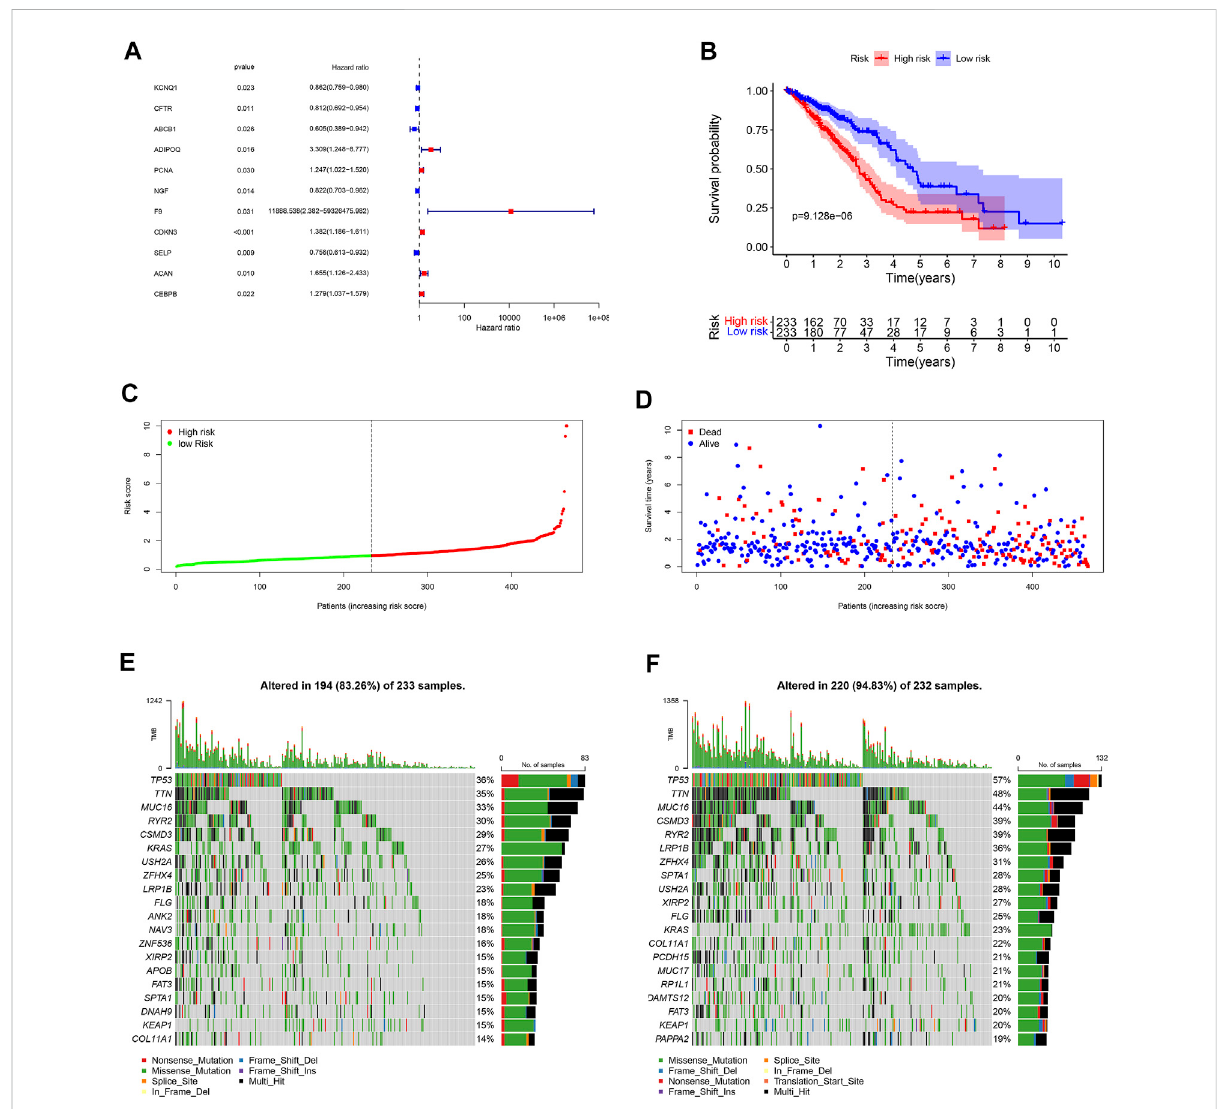
FIGURE 4 LandscapeofUPPandprognosisinLUAD. (A) 11UPP-relatedgeneswereobtainedbyunivariateCoxanalysis. (B) Survivalanalysisbetweenhigh- andlow-risk groups. (C) The riskscore curveofall LUAD patients intheTCGA. (D) The scatter plotofLUAD survivaltime periods intheTCGA. (E) The Oncoplot of the low-risk group in LUAD. (F) The Oncoplot of the high-risk group in LUAD. Oncoplot shows the list of top 20 genes ordered by the number of samples with the gene variants, and the percentage represents the ratio of samples with gene variation to total